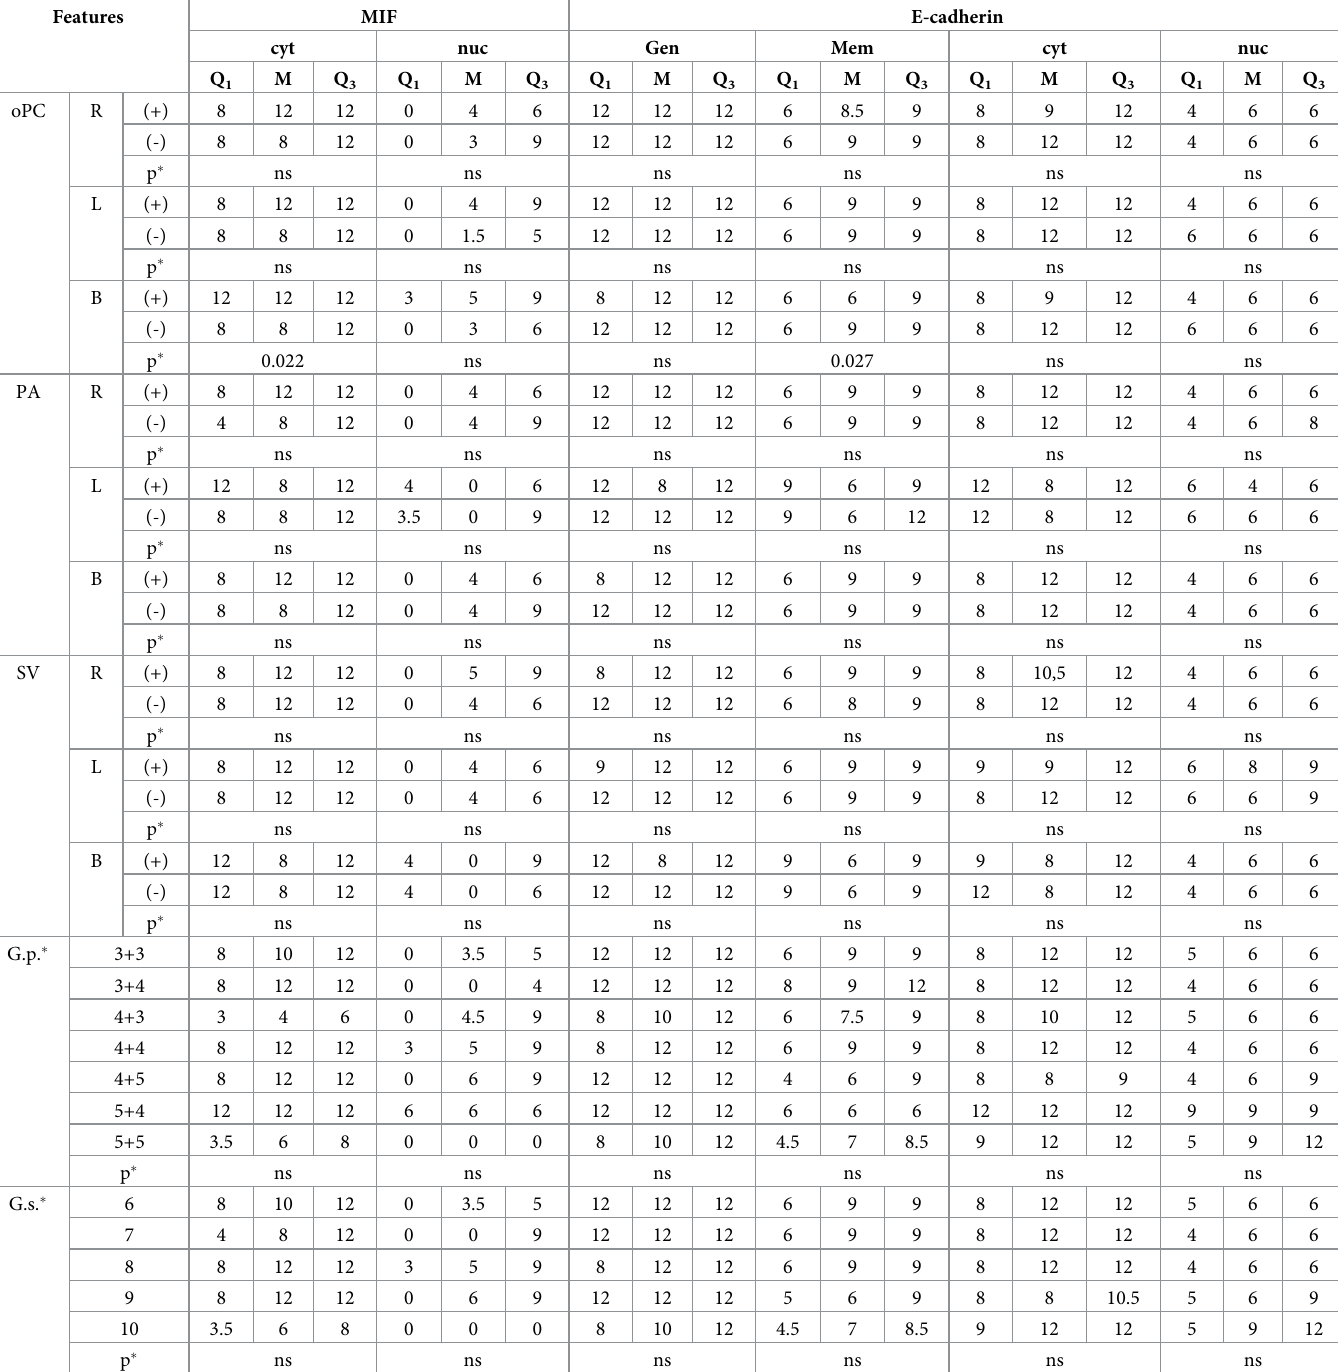
Table 6. Correlations between MIF and E-cadherin and invasion area and histological grading of tumor tissue which has grown through the prostate.